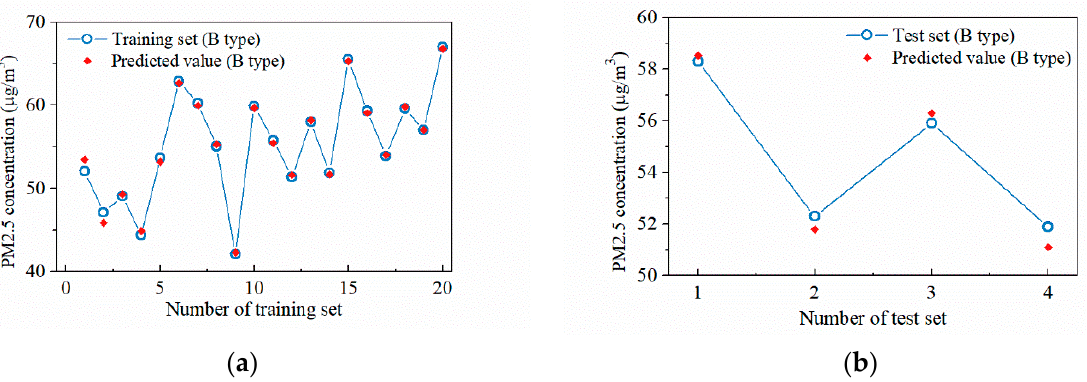
Figure 18. Regression result of the B-type sampling points at the concourse floor: ( a ) Training set; ( b ) Test set.